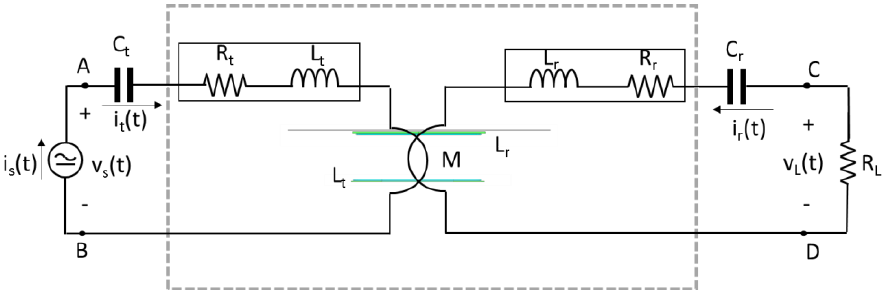
Figure 3. FEM model coupled with the circuit.